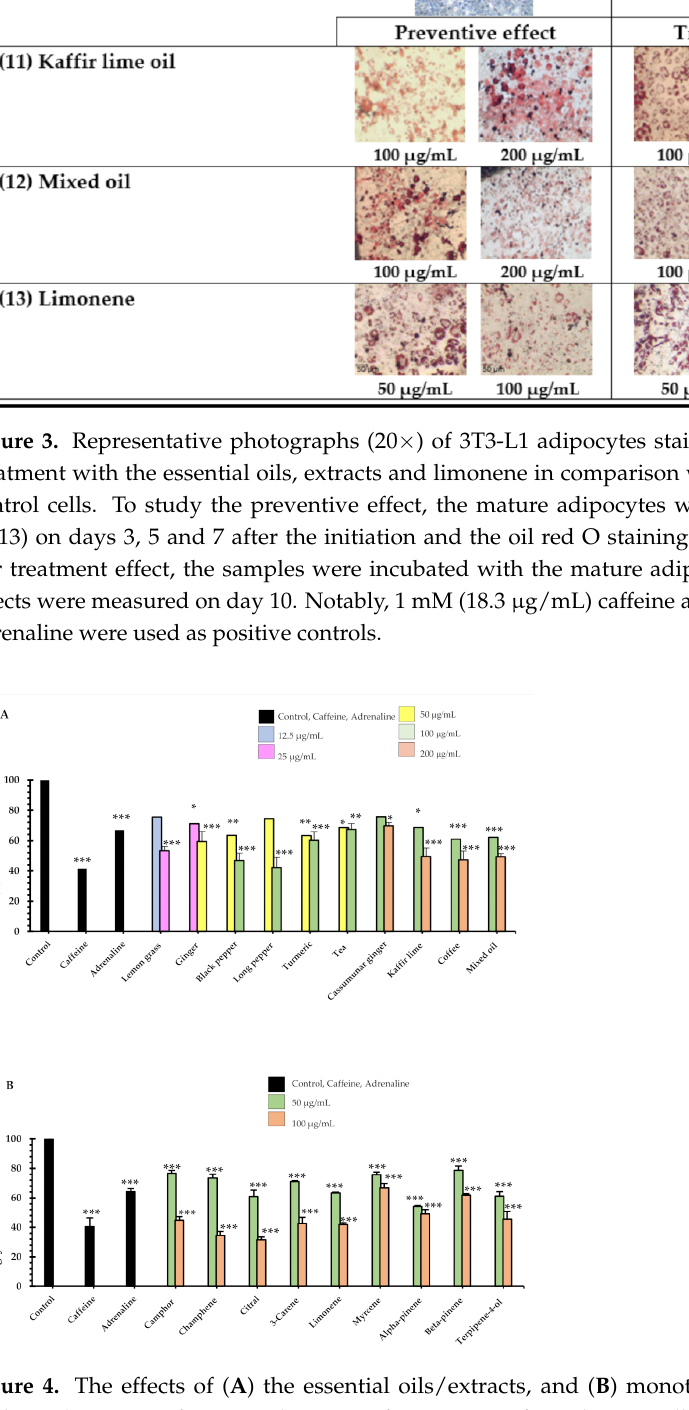
Figure 4. The effects of ( A ) the essential oils/extracts, and ( B ) monoterpenoid constituents on triglyceride content of 3T3-L1 adipocytes after treatment for 24 h. Intracellular triacylglycerol content was determined using enzymatic colorimetric methods. We used 1 mM (18.2 µ g/mL) caffeine and 0.1 mM (194.3 µ g/mL) as positive controls. Values are expressed as mean ± SE of three independent experiments. One-way ANOVA showed significant value, * p < 0.05, ** p < 0.01, and *** p < 0.001 vs. control cells